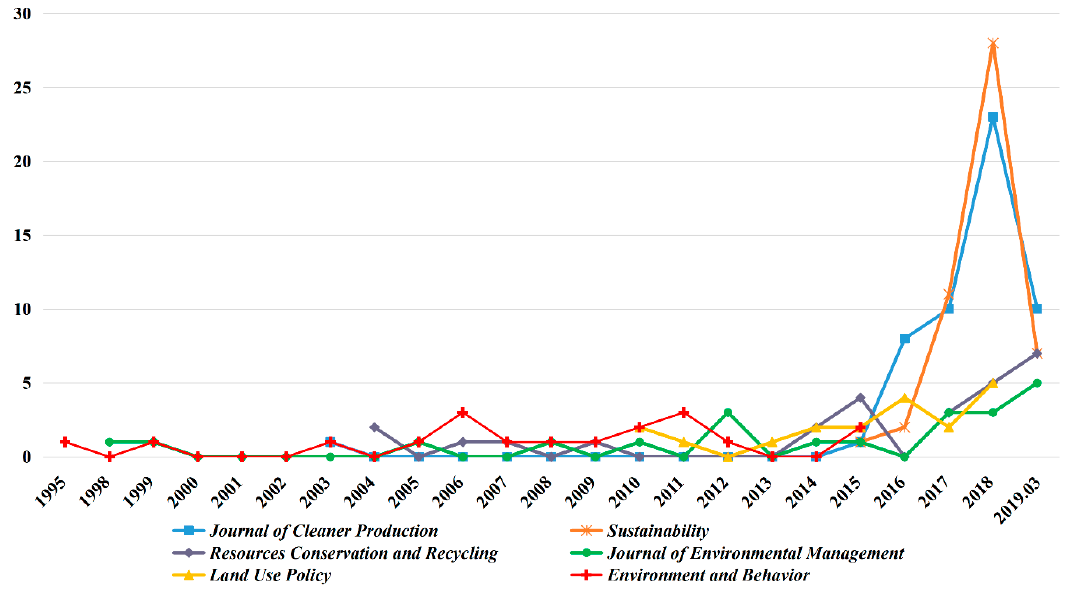
Figure 5. Publication statistics on the application of the TPB to environmental science.